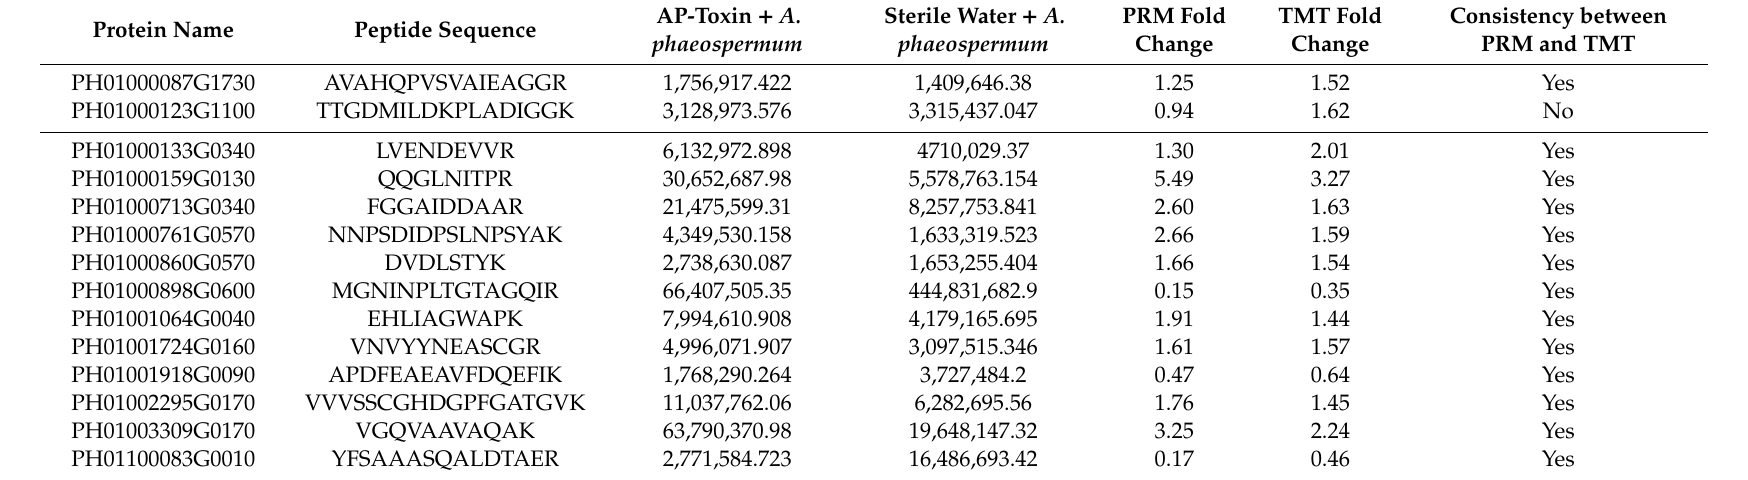
Table 3. Quantitative results for 14 candidate proteins determined using the PRM and tandem mass tag (TMT)